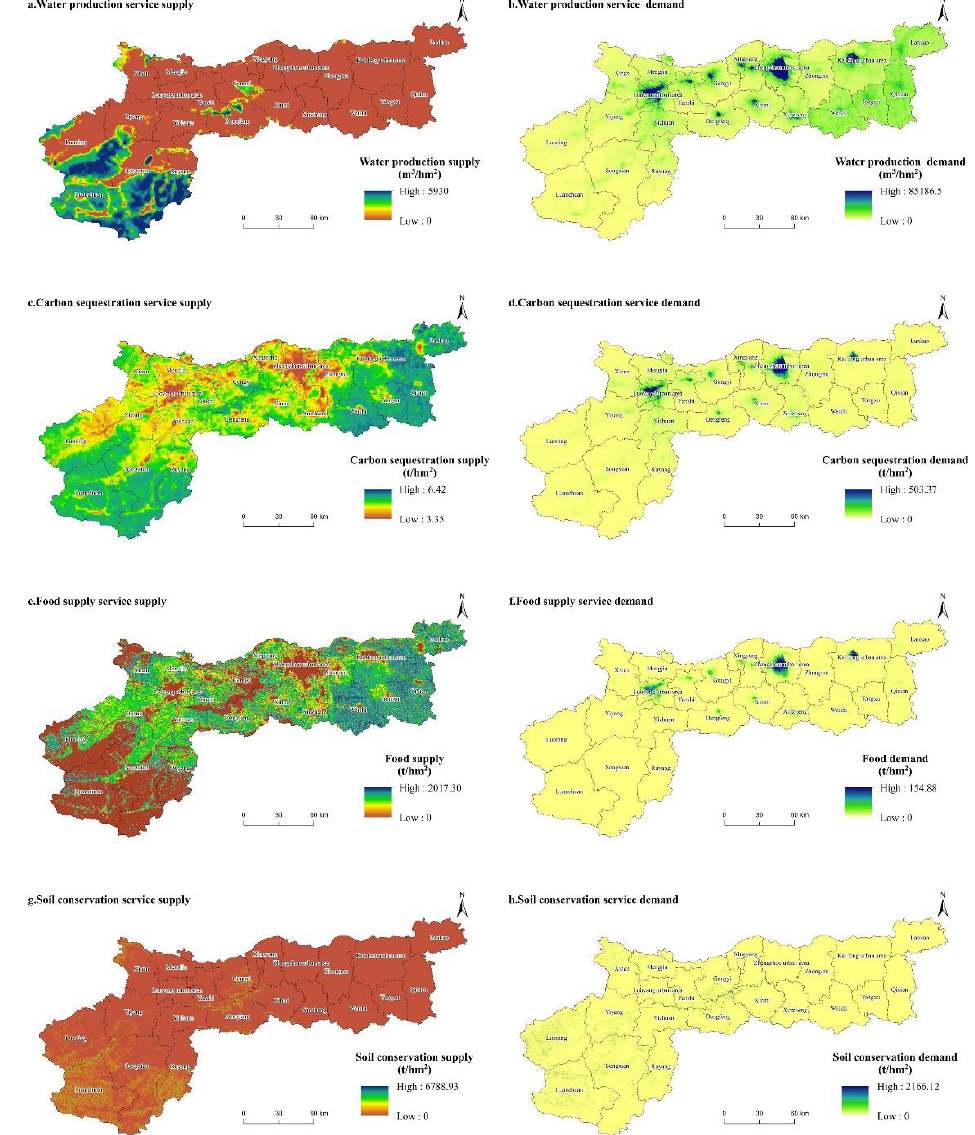
Figure 2. Spatial distribution of ( a ) water production service supply, ( b ) water production service demand, ( c ) carbon sequestration service supply, ( d ) carbon sequestration service demand, ( e ) food supply service supply, ( f ) food supply service demand, ( g ) soil conservation service supply, and ( h ) soil conservation service demand in the ZKL urban agglomeration.